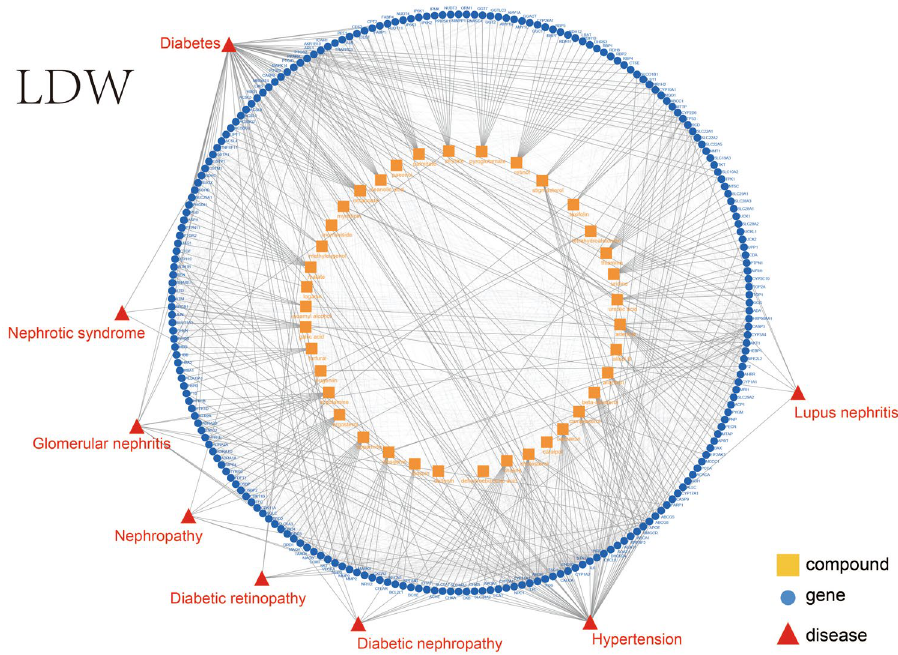
Figure 5. The pharmacology network generated for LDW. The innermost circle represented the compounds collected from LDW, the circle in the middle represented the related genes of compounds from LDW, the outermost layer represented the diseases that were related to the genes. Node: yellow square, compound; blue circle, gene; red triangle, disease. Line: the line between yellow square and blue circle, compound-gene links; the line between blue circle and red triangle, potential links between gene and